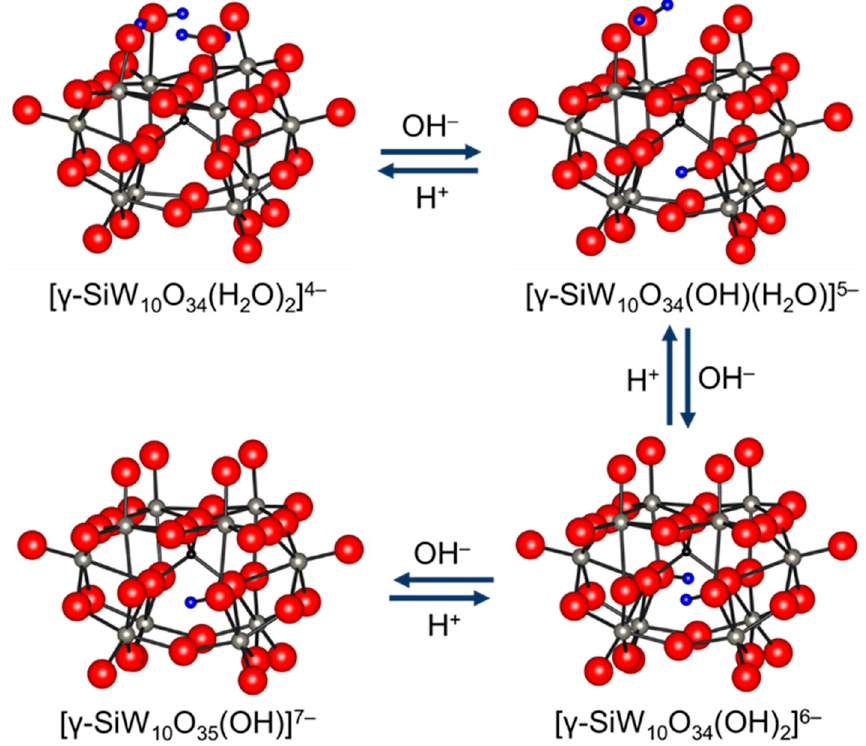
Figure Figure 5. Reversible changes among [ γ -SiW 10 O 34 (OH)(OH 2 )] 5 − , [ γ -SiW 10 O 34 (OH) 2 ] 6 − , and [ γ - SiW 10 O 35 (OH)] 7 − thorough protonation/deprotonation [91].